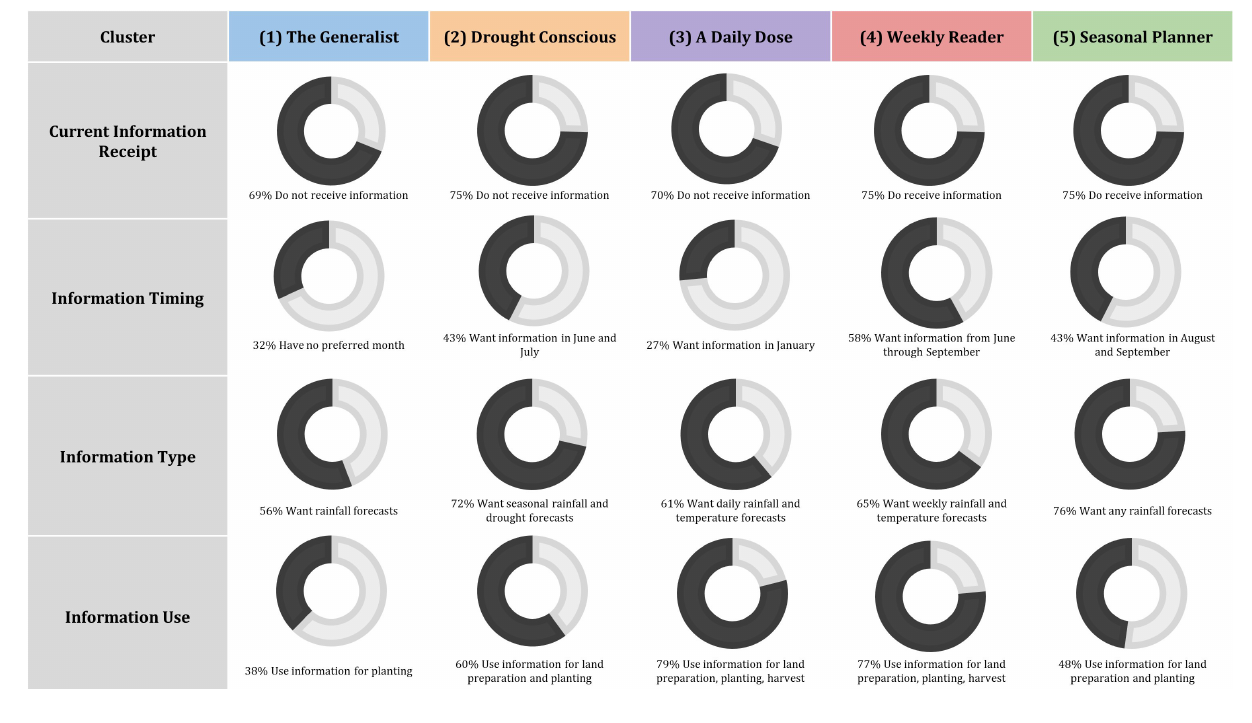
FIGURE 2 | Typology of climate information needs based on the cluster